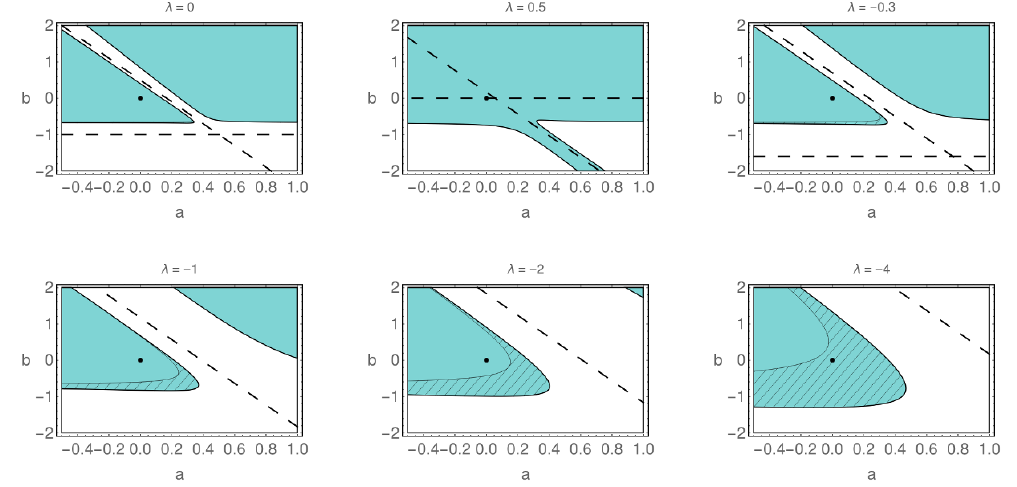
Figure 12 . Viable region for predictive Higgs mass for several values of the dimensionless cos- mological constant within the standard ASQG framework. The region with diagonal solid lines indicate the set of values where gravity-induced (cid:12)xed points for the Yukawa and (non-)Abelian gauge coupling can by achieved along with a predictive Higgs mass. The dashed lines indicate the poles 1 + b (cid:0) 2 (cid:21) (TT-mode) and 1 (cid:0) 6 a (cid:0) 2 b (cid:0) 4 (cid:21) = 0 (trace 3